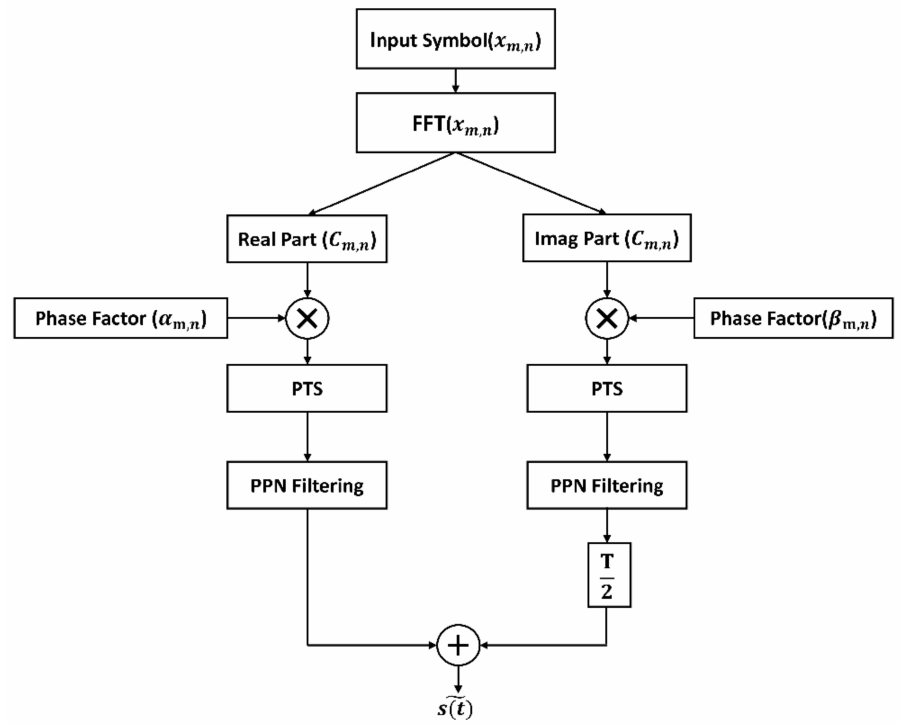
Figure 4. Block diagram of the proposed